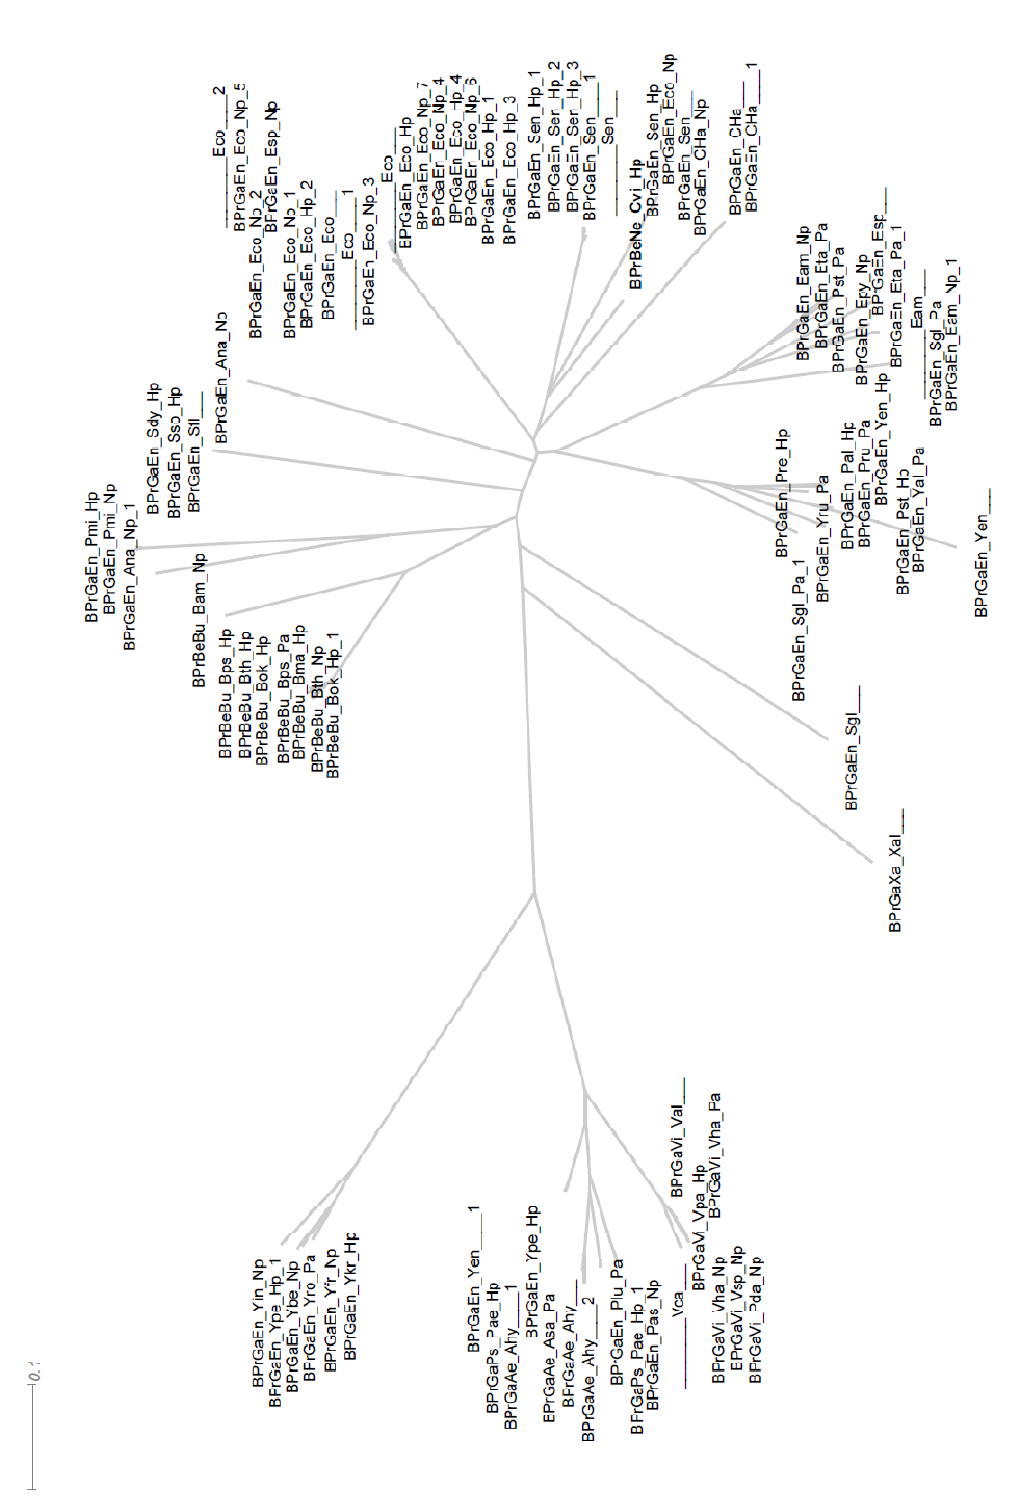
Fig. 2: A phylogeny for SpaP proteins. The sequences were collected by using BLAST and stored in a multiple fasta file. The resulting file was processed by means of Jalview [15] and SplitsTree4 [17]. Labels created by utilizing Key2Ann and the options superkingdom phylum class order pathogenicity replaced the NCBI-labels. The first characters indicate the phylogenetic lineage. For BPrBeNe_Cvi_Hp it is “B” Bacteria, “Pr” proteobacteria, “Be” beta- proteobacteria, “Ne” Neisseriales. “Cvi” is an abbreviation of the species name. Suffixes “Hp”, “Pa”, and “Np” indicate whether a species is known to be a human pathogen, a pathogen, or a non-pathogenic species. The tree makes clear that both pathogenic and non-pathogenic species possess this protein and that phylogenetic relation is the driving force for the grouping and